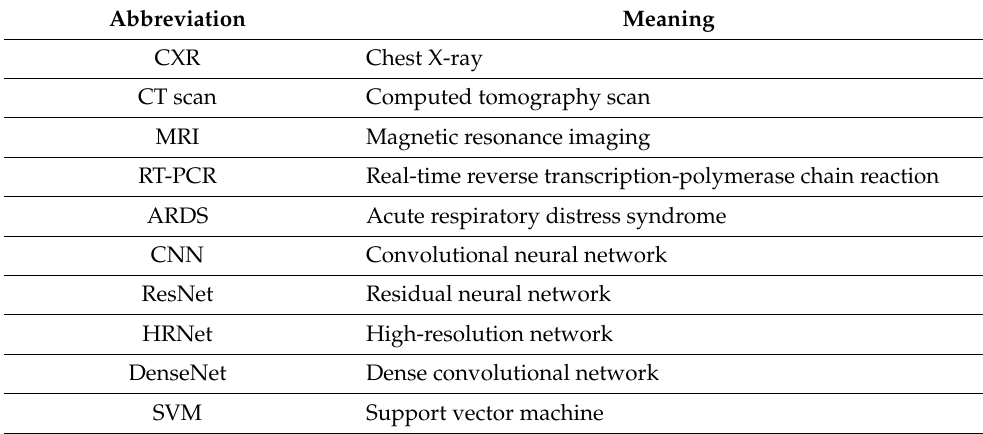
Figure 2. The framework of the proposed doctor consultation-inspired model. In particular, there are two fusion mechanisms, namely early fusion and late fusion. The final output of either mechanism is the prediction label. Table 2. Table of abbreviations/acronyms used in this